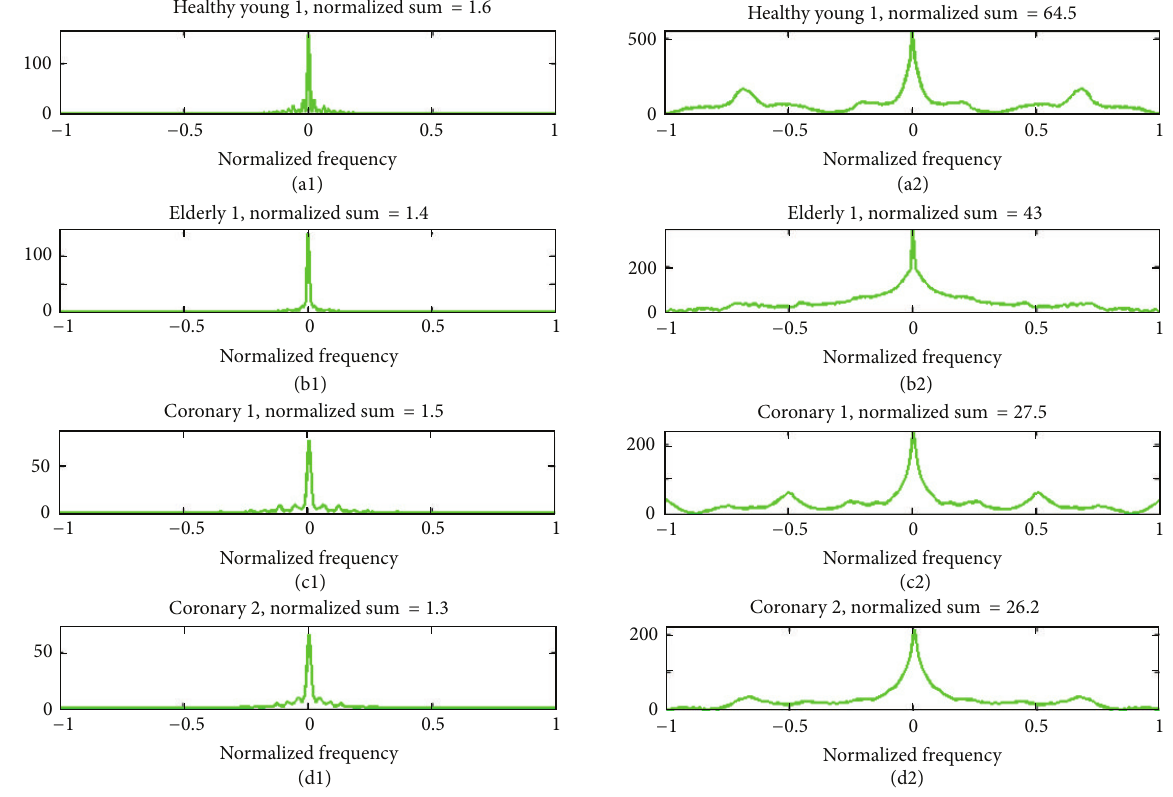
Figure 15: The plots in the left column (a1, b1, c1, and d1) show four spectral curves, each of which is the average of the columns of the spatiospectral 2D map corresponding to one of the four cases presented in Figure 14. The right column shows four plots (a2, b2, c2, and d2), denoted as FT 2 curves, each of which presents the result of applying the Fourier transform to the corresponding spectral curve in the left column. Normalized sums of the areas under each spectral curve and each FT 2 curve are also